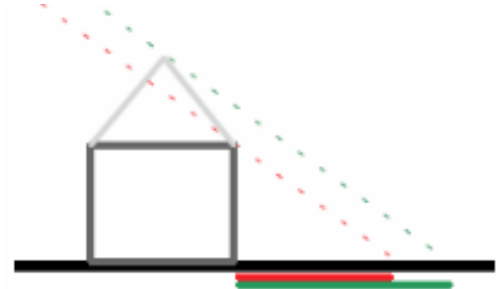
Figure 5. Effect of LoD1 and LoD2 in shadow calculation. (Biljecki et. al., 2013).